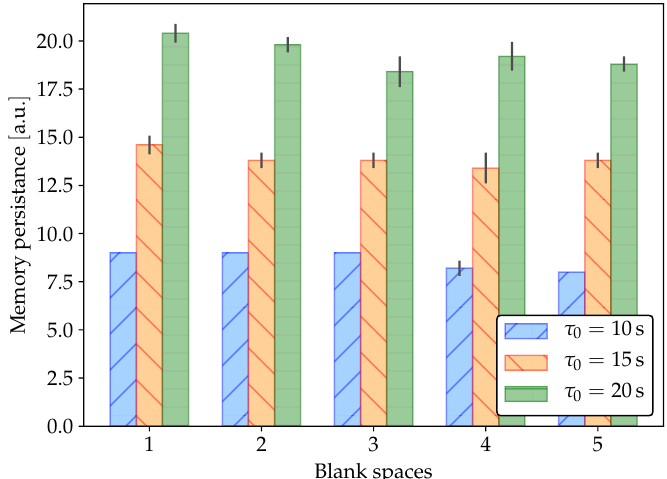
Figure 13. Memory persistence in Pavlovian conditioning. Results correspond to five experiments in the same conditions as in Figure